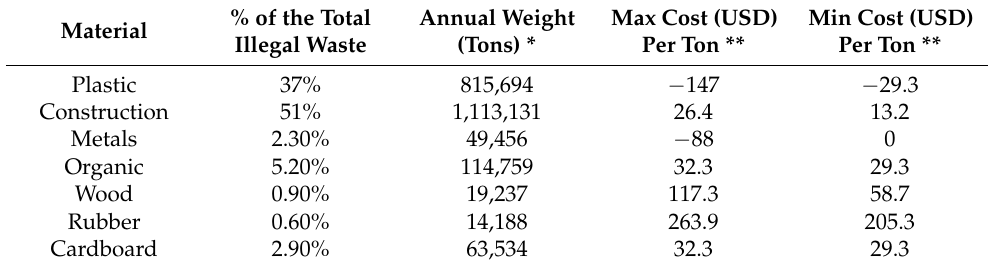
Table 5. Economic analysis of the price ranges and annual weight estimates on a national level. Material